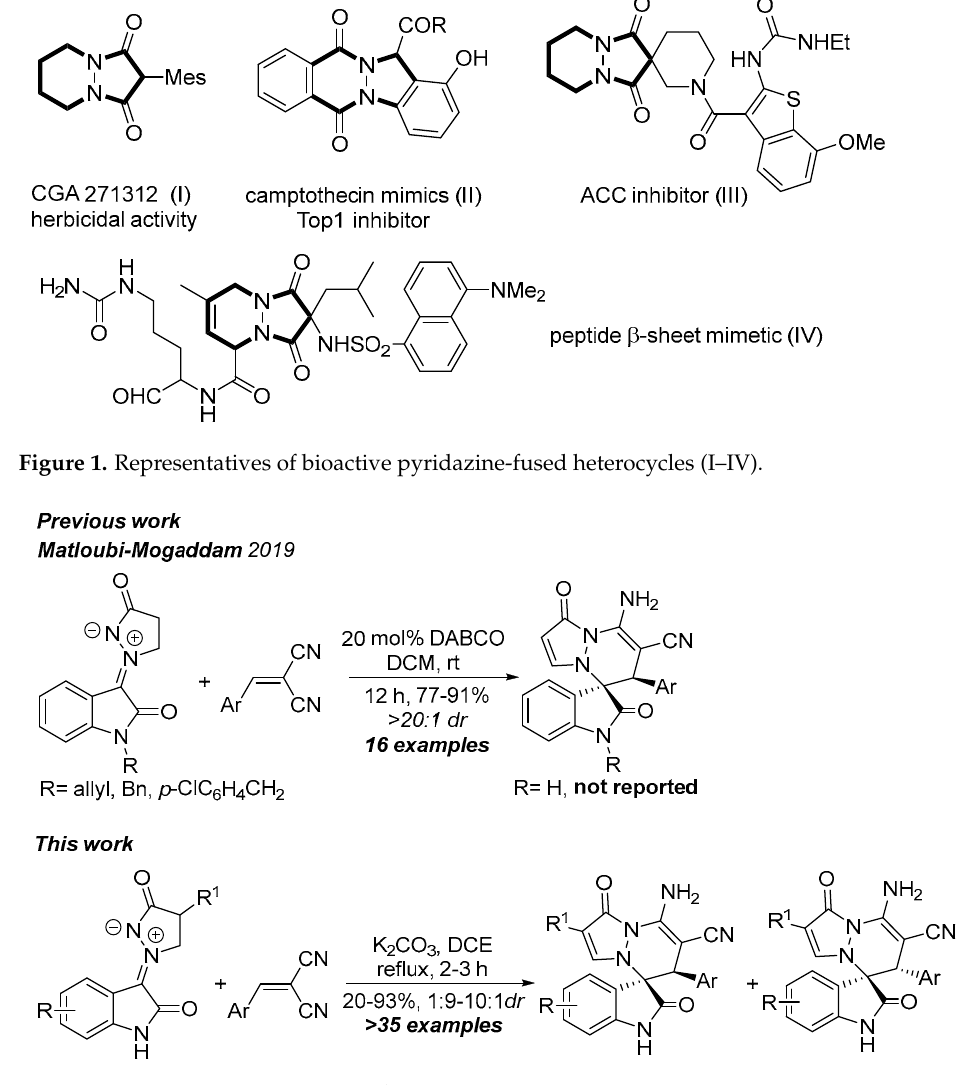
Table 1. The condition optimization of model reaction a .